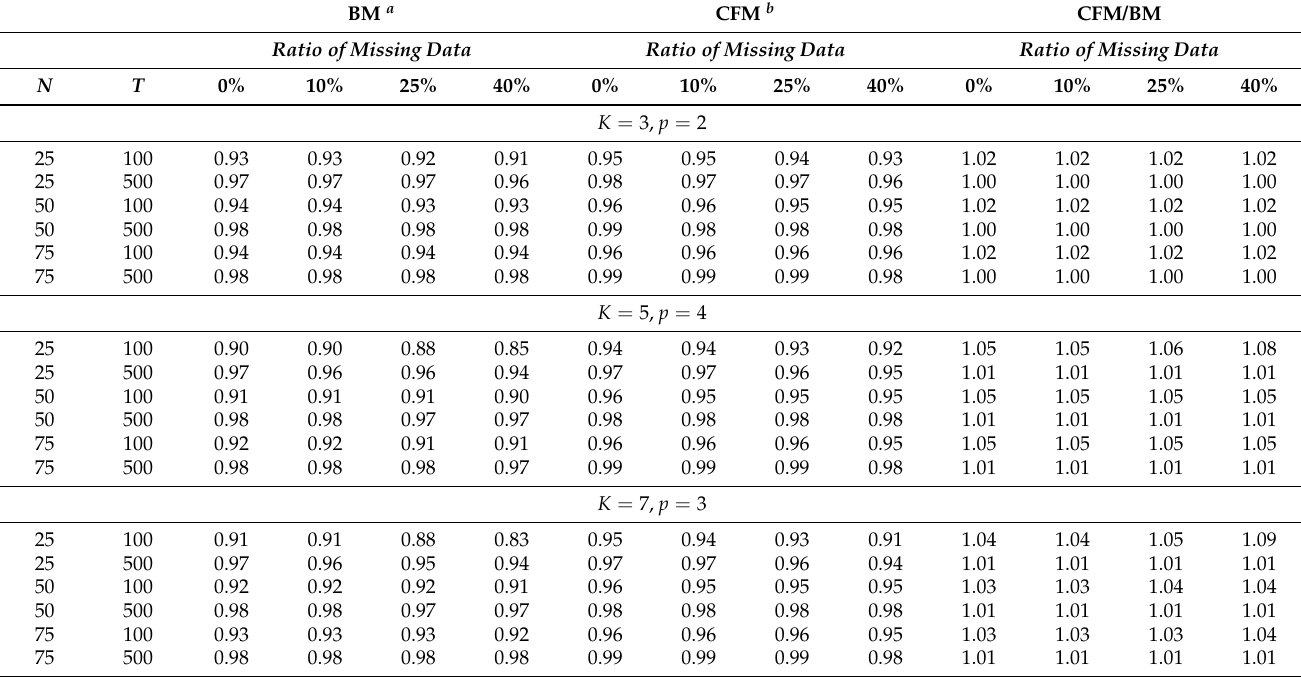
Table A4. Comparison of trace R 2 means for random ADFMs using the approach of [20] and our two-step estimation